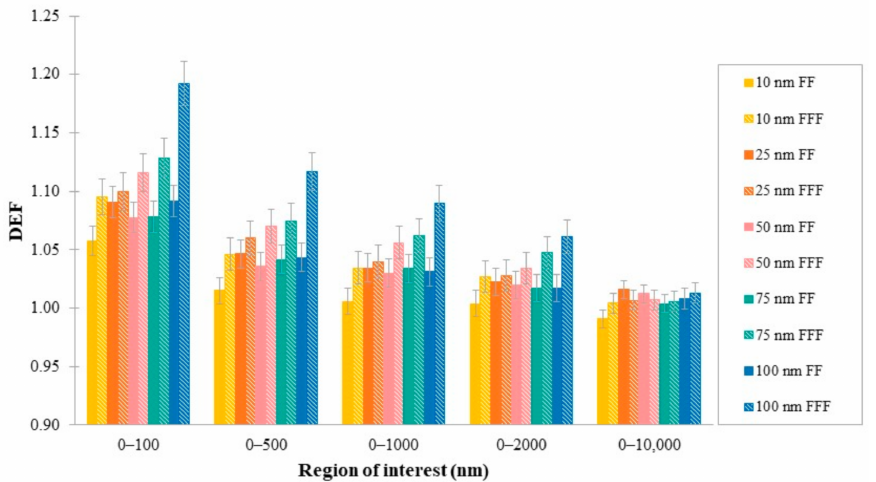
Figure 4. Average DEF, for different sizes of AuSlabs, in regions of interest.